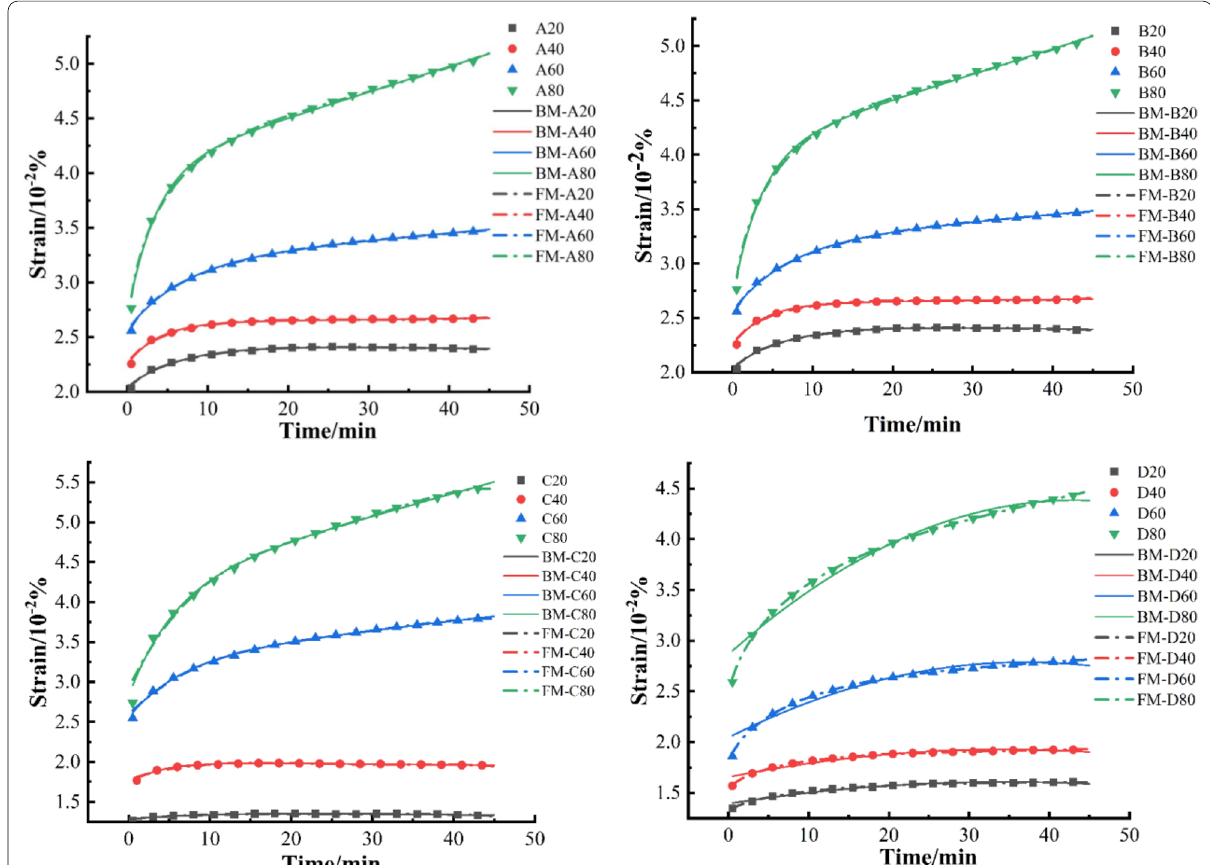
Fig. 8 Comparison between the model simulation and experimental points of white oak specimens at different